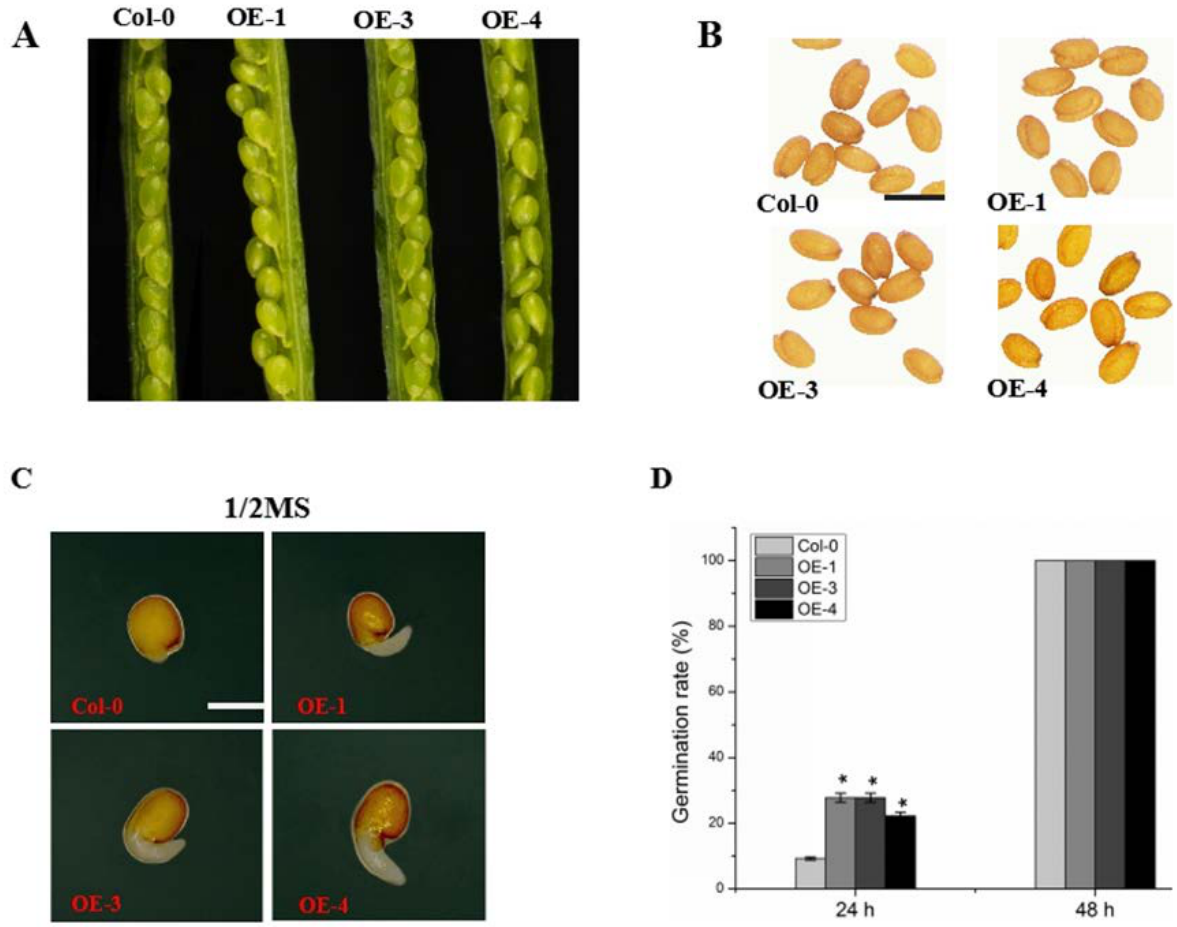
Figure 3. Overexpression of GmABCA7 promoted seed germination in Arabidopsis. ( A ) Siliques at 12 days after flowering (12 DAF). ( B ) Seeds of the wild type and three transgenic lines (OE-1, OE-3 and OE-4). Scale bar = 500 µm. ( C ) Seed germination at 24 h after sowing on 1/2 MS medium. Scale bar = 0.5 mm. ( D ) Germination rates of wild type and GmABCA7 transgenic seeds were measured 24 h and 48 h after sowing on 1/2 MS medium. The wild type and GmABCA7 transgenic seeds (OE-1, OE-3 and OE-4) were grown with a photoperiod of 16 h, 22 °C/8 h, 20 °C (light/dark, respectively). Values are means ± SE of three independent experiments each using 18 seeds. Asterisks indicate a significant difference compared to the corresponding controls (* p <